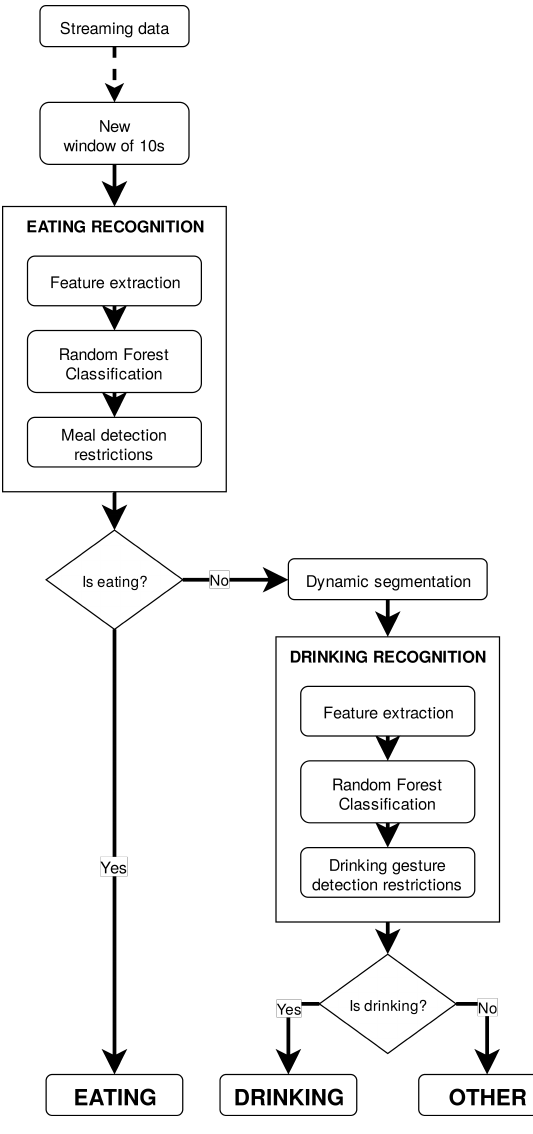
Figure 2. Semi-hierarchical flow of operations of the eating and drinking recognition algorithm. Other includes all non-eating and non-drinking daily living